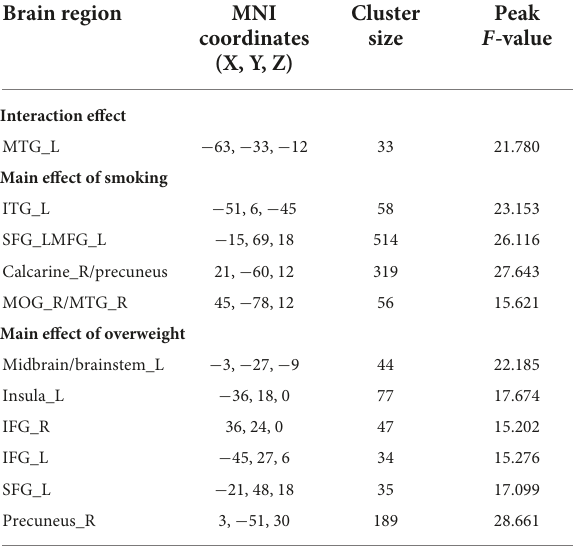
TABLE 2 Significant group differences in amplitude of low-frequency